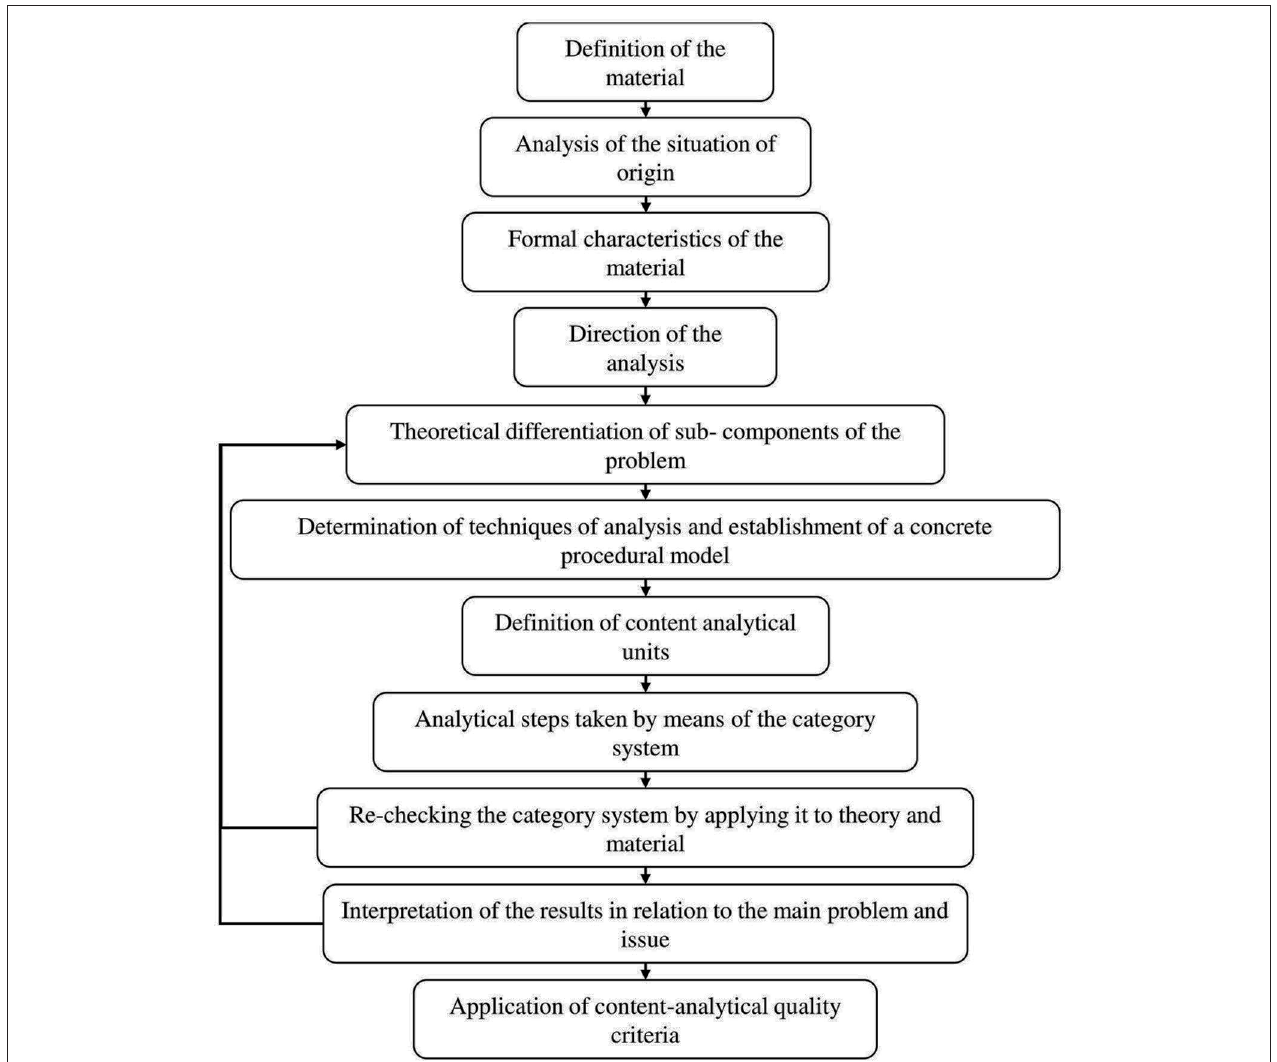
FIGURE 2 | Qualitative content analysis